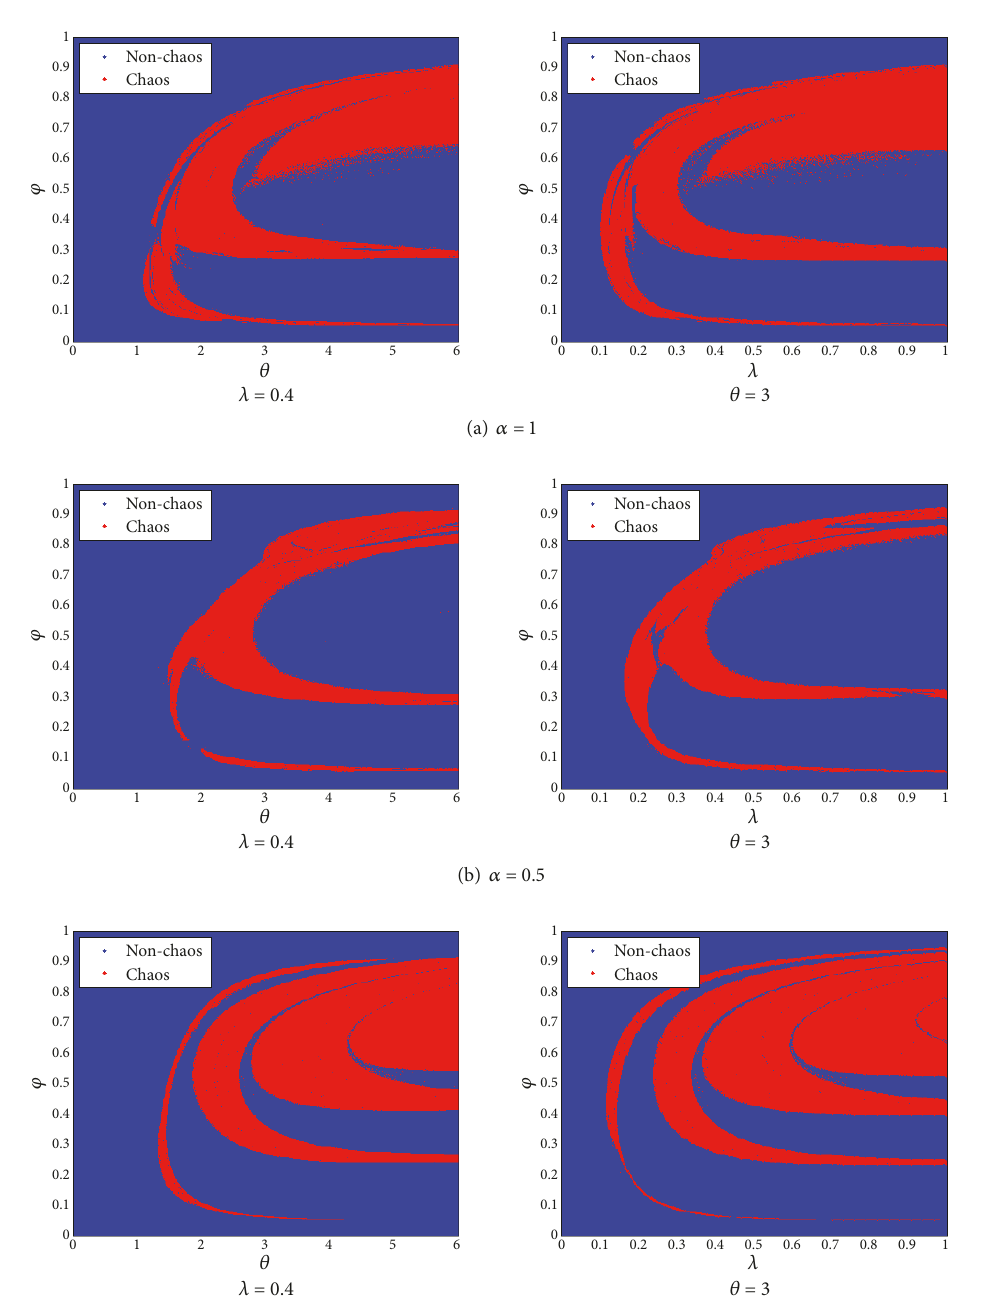
Figure 5: System state for different value of 𝛼